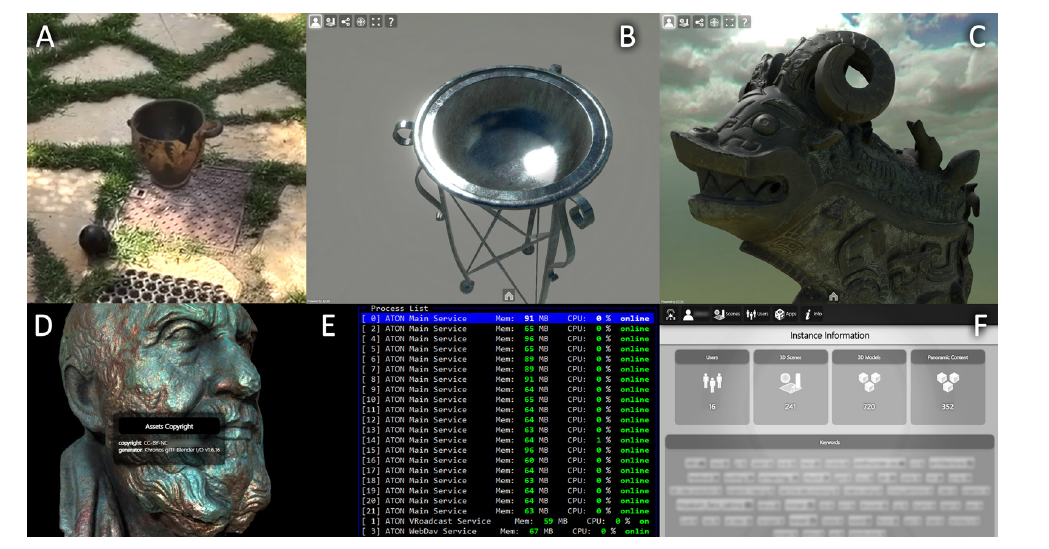
Figure 23. ( A ) AR Presentation of a 3D scene; ( B ) A PBR asset directly exported from Unreal Engine 4; ( C ) A 3D scene referencing an external 3D model from Smithsonian CC0 collection; ( D ) Inline copyright from glTF; ( E ) Workload distribution among available cores; ( F ) Instance content